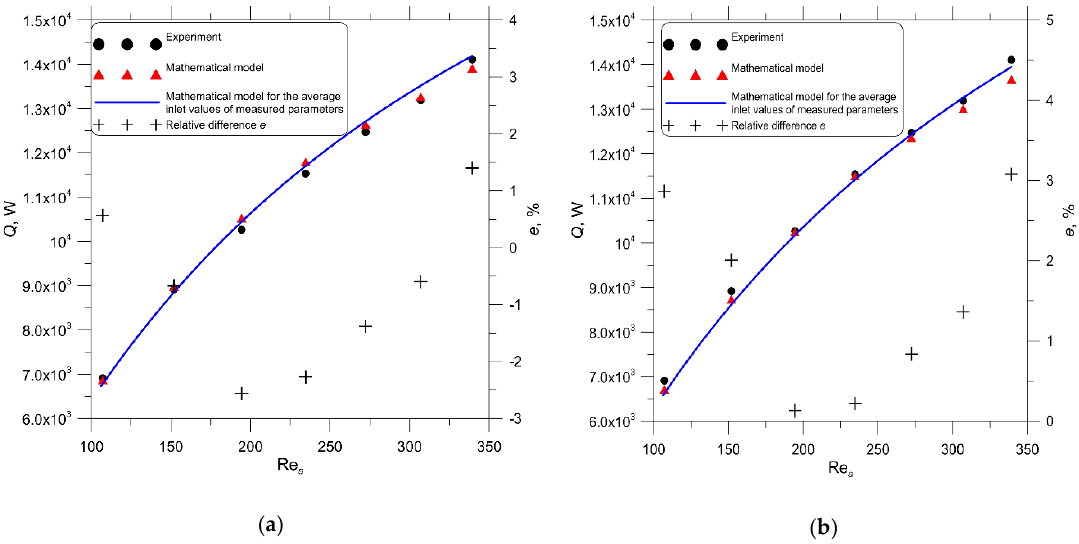
Figure 5. The thermal output Q of the car radiator; 1: Q w , exp values determined using the measurement results, 2: thermal output Q w , calc calculated with the air-side Nusselt number Nu a obtained by CFD simulation ( a ) or empirical Equation ( b ), 3: thermal output Q w , calc obtained using the CFD-based